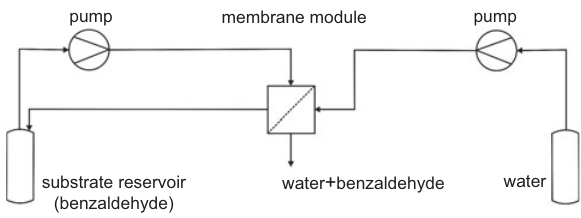
Figure 5 Set-up for the analysis of the substrate feed.